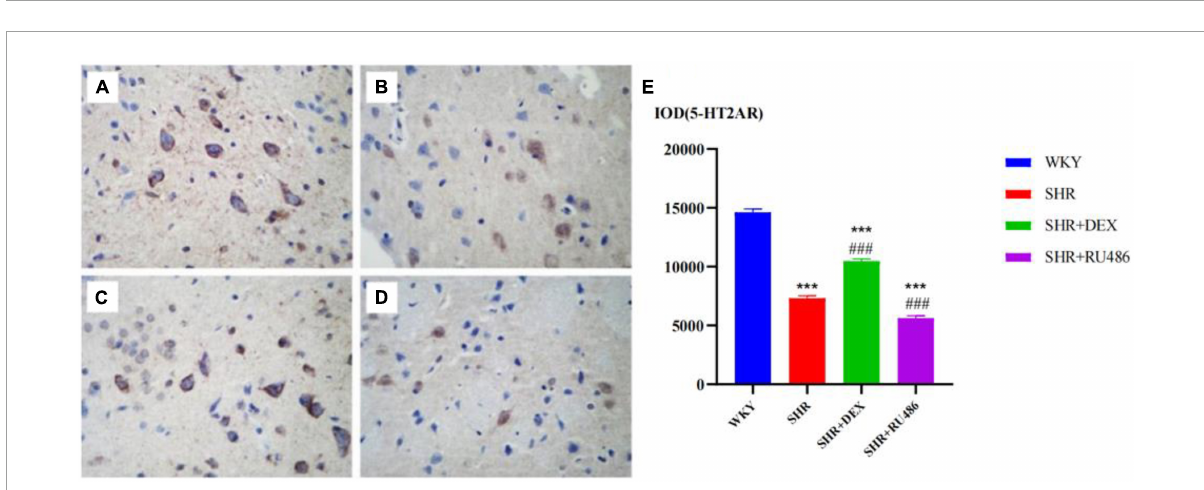
FIGURE7 Comparison of 5-HT1A receptor (5-HT2AR) levels in the prefrontal cortex of rats in four groups ( × 400) [ (A) Wista Kyoto rats (WKY) group; (B) spontaneously hypertensive rats (SHR) group; (C) SHR + dexamethasone (DEX) group; (D) SHR + RU486 group]; Comparison of 5-HT2AR levels in the prefrontal cortex of rats in four groups (E) . One-way analysis of variance (ANOVA) with repeated measures followed by post hoc with Tukey test. All data are presented as mean ± SEM. *** p < 0.001, compared to WKY group; ### p < 0.001, compared to SHR